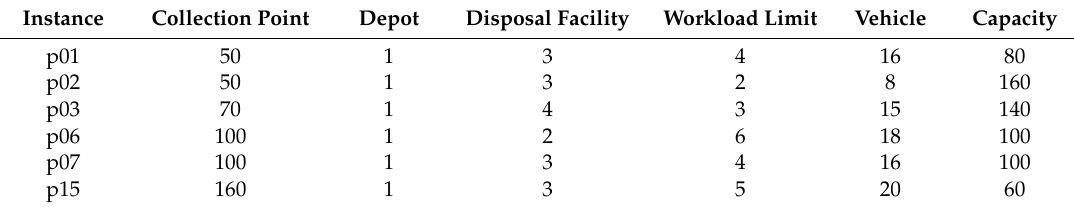
Table 5. Data of the test instances.